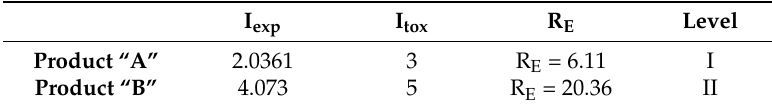
Table 14. Scores related to the calculation of the exposure